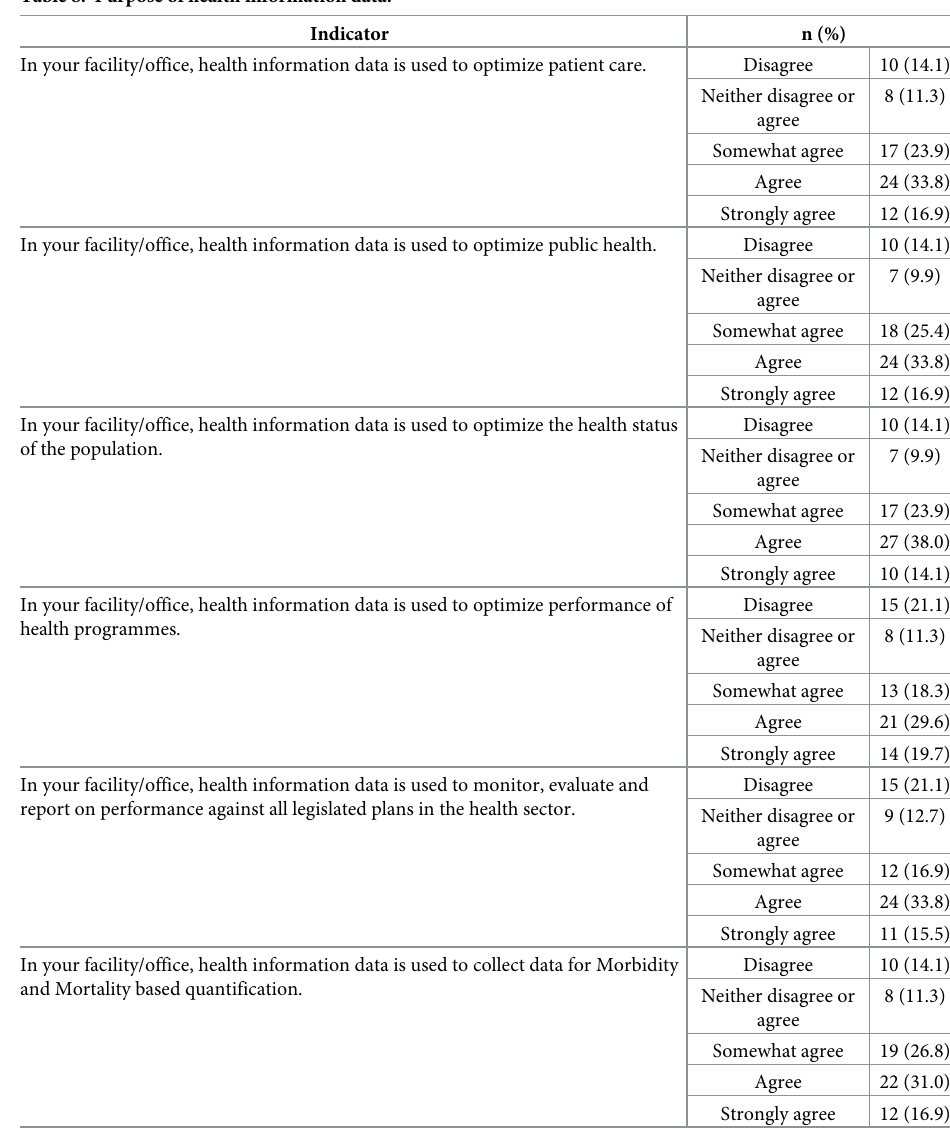
Table 8. Purpose of health information